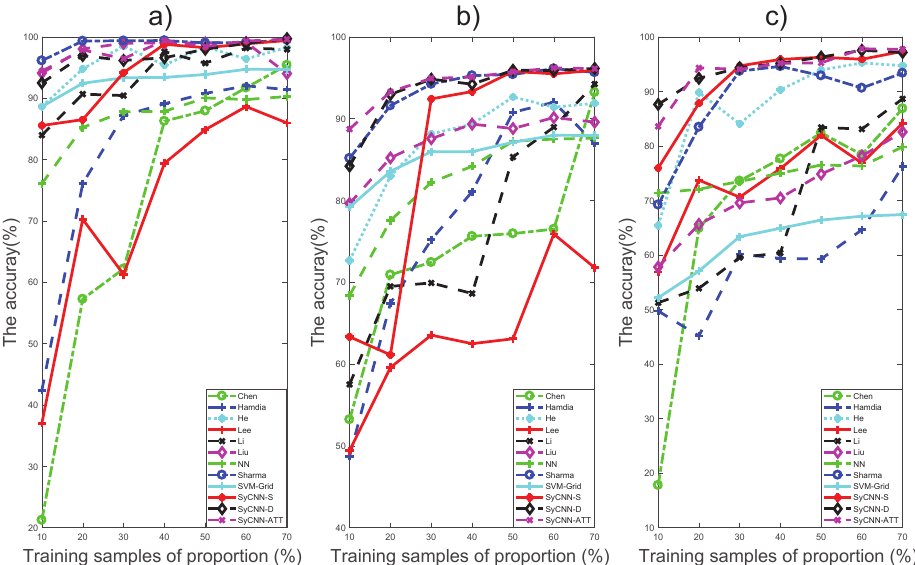
Figure 11. Visualization of the influence of training samples proportion for different methods based on the three datasets: ( a ) Indian Pines, ( b ) Botswana, ( c ) KSC. It can be observed that the results of our proposed models are very stable and better than the comparison